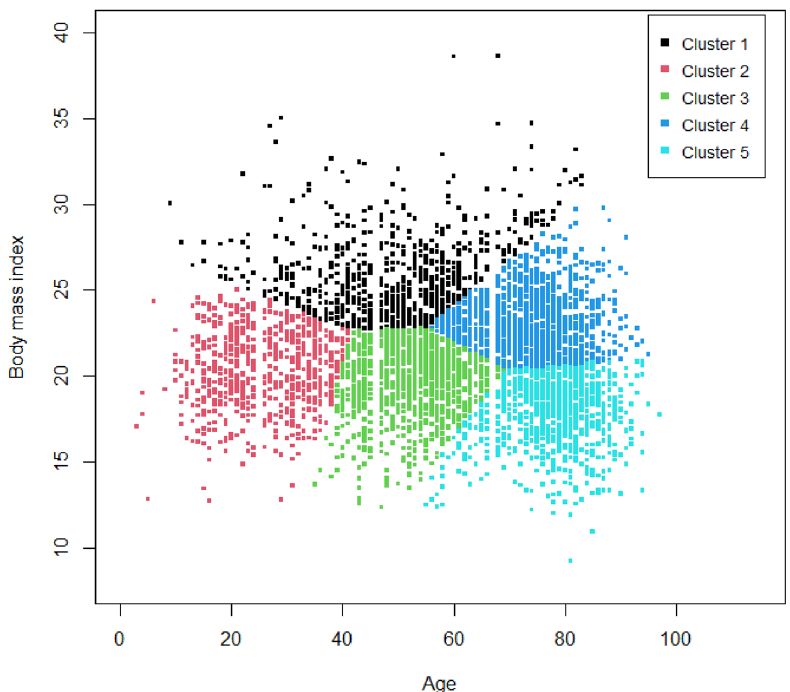
Figure 2. Distribution of each of the five clusters by age and body mass index. X and Y axis means age and body mass index, respectively. Cluster analysis was performed using K-means clustering using kmeans function in the stats package. Two variables—age and BMI—which were considered to contribute to the specific TB phenotype in the correlation network were selected. Colour of cluster indicates each cluster (black: cluster 1, red: cluster 2, green: cluster 3, blue: cluster 4, and sky-blue: cluster 5).